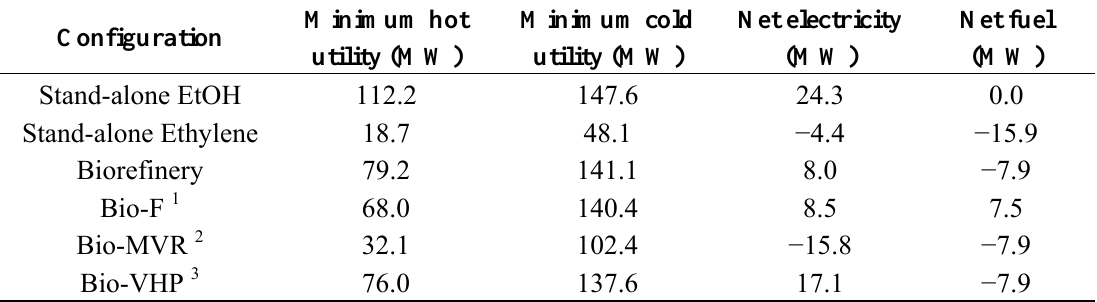
Table 5. Comparison of ethanol to ethylene plant configurations